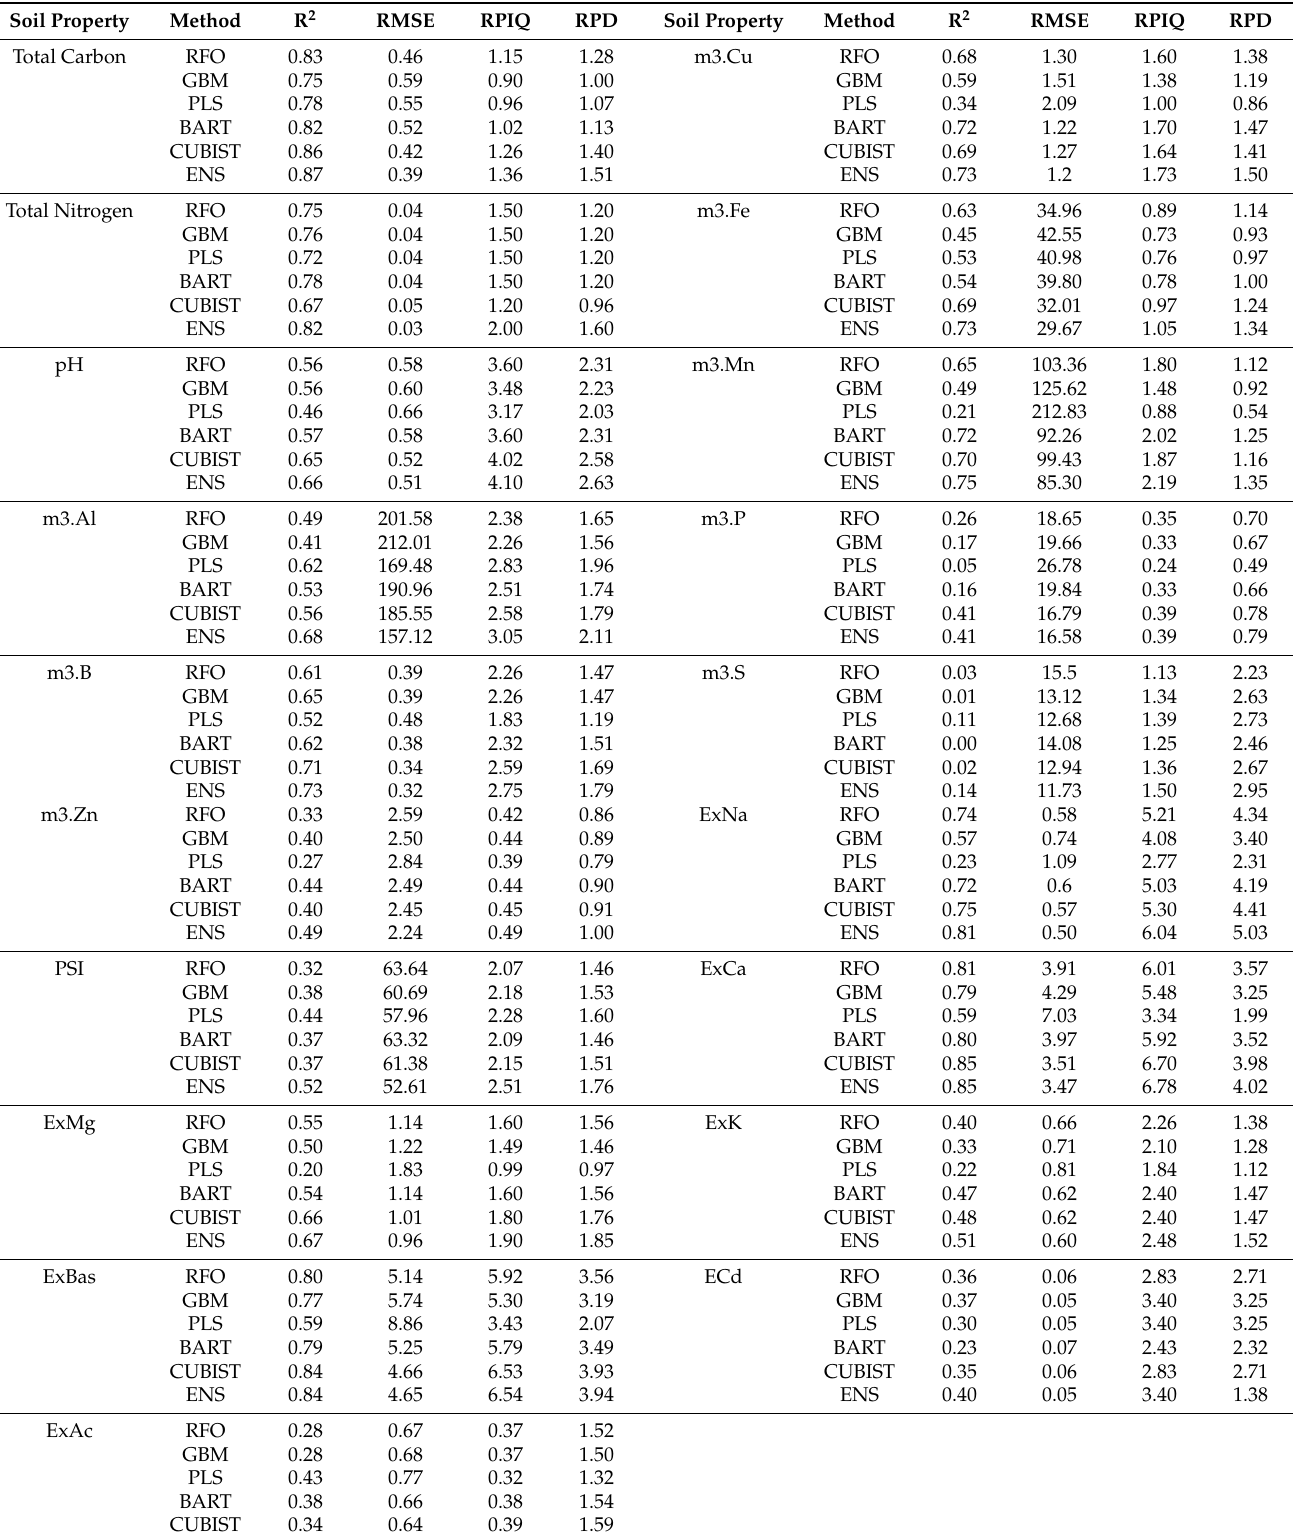
Table 2. Comparison of prediction accuracy from six machine learning algorithms using soil NIR